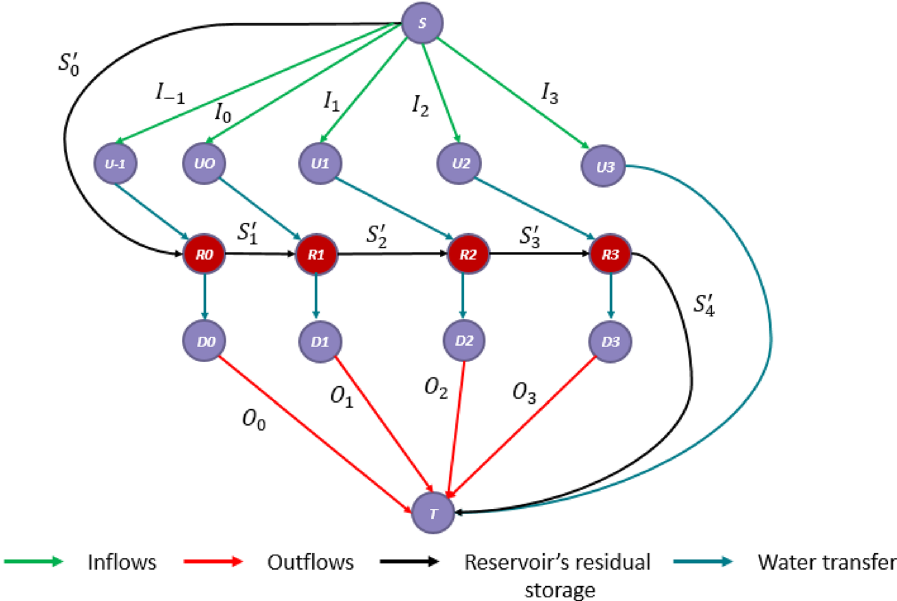
Figure 3. Network model corresponding to a reach, with TT = 1 and Horizon = 4